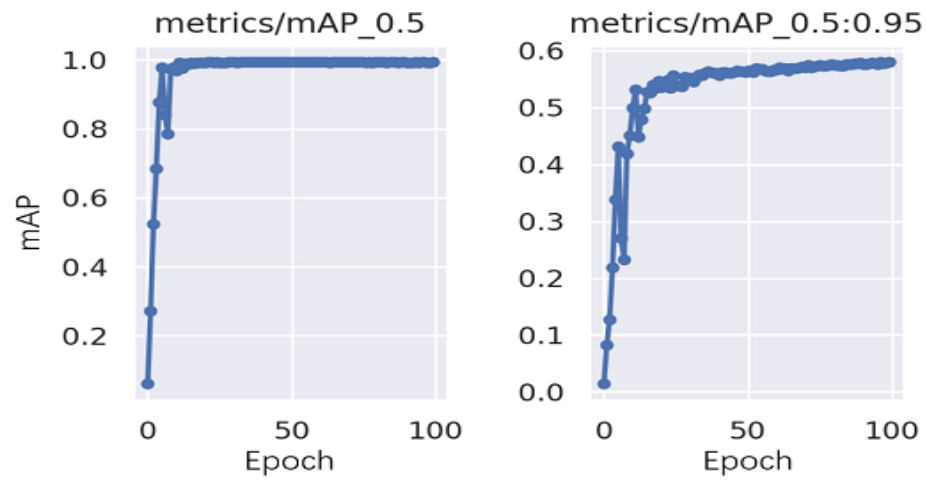
Figure 8. Mean average precision (mAP) graphs for the categories. mAP_0.5 represents the mAP value when the intersection over union (IoU) is 0.5; mAP_0.5:0.95 represents the average mAP at different IoU thresholds (from 0.5 to 0.95 in steps of 0.05) (0.5, 0.55, 0.6, 0.65, 0.7, 0.75, 0.8, 0.85, 0.9, 0.95).